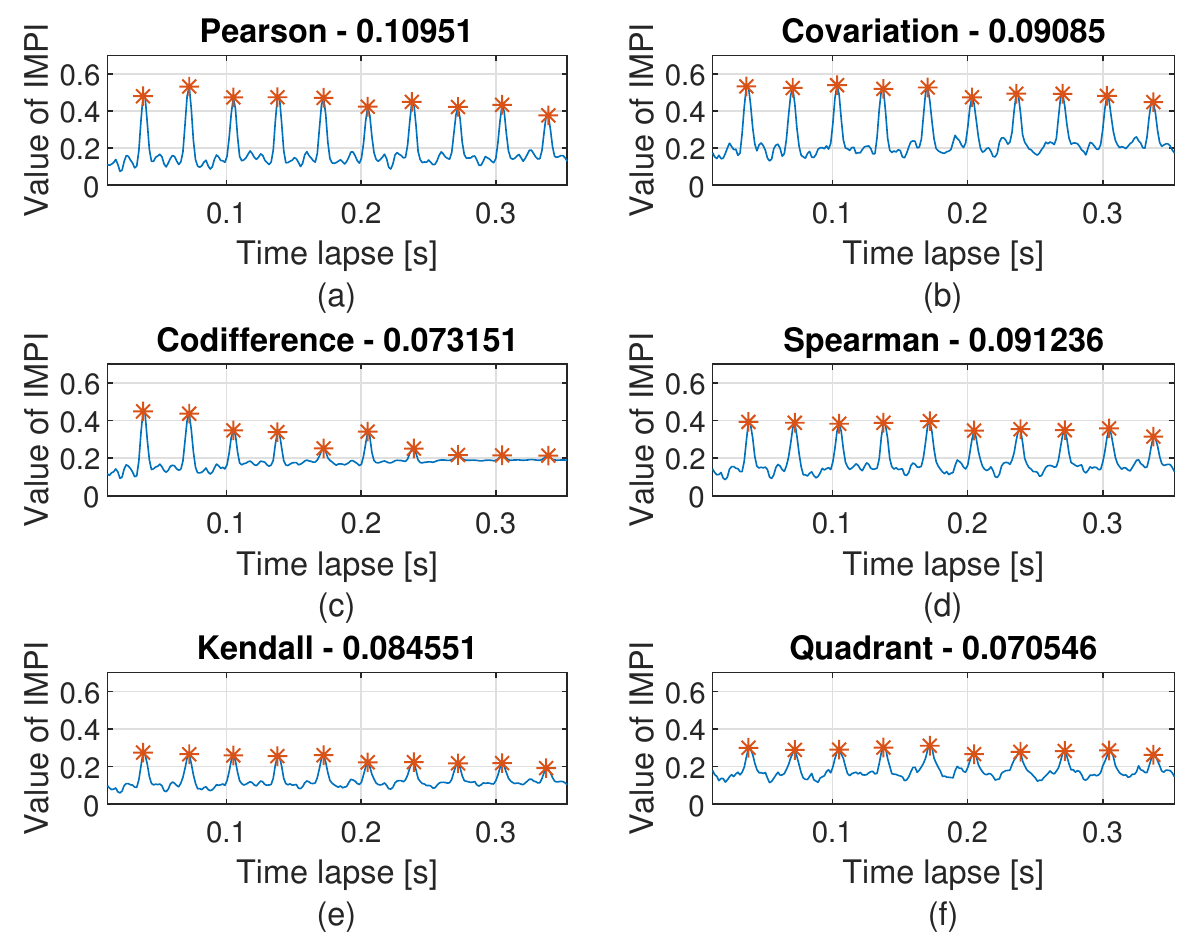
Figure 8. The results of IMPI calculated from auto-similarity maps only for IFB (2.5 kHz), in the case of different measures of dependence: ( a ) Pearson autocorrelation, ( b ) autocovariation, ( c ) autocodifference, ( d ) Spearman autocorrelation, ( e ) Kendall autocorrelation, ( f ) Quadrant autocorrelation—simulated signal.